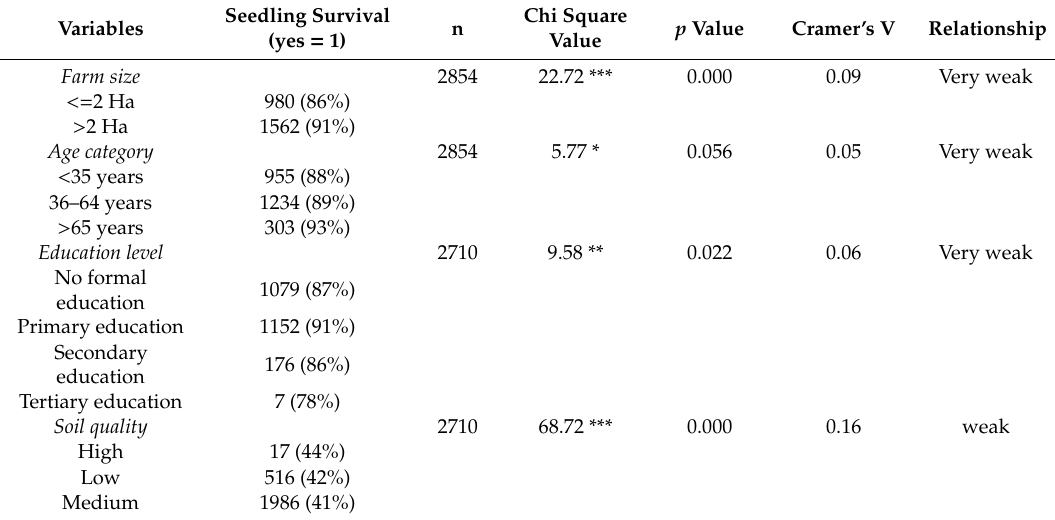
Table 8. Results of the chi square test for a relationship between seedling survival and socioeconomic characteristics of a household and biophysical characteristics of the farm in Ethiopia.